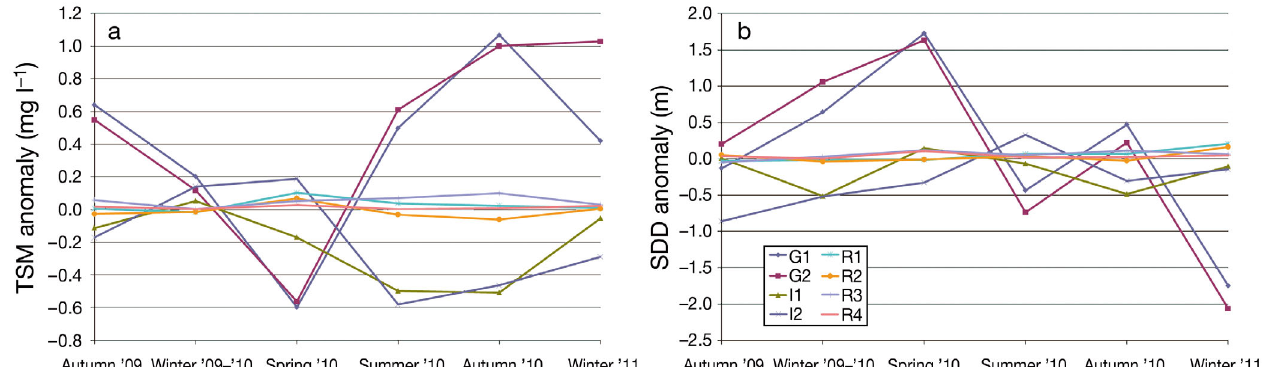
Fig. 6. Seasonal anomalies of (a) total suspended matter (TSM) and (b) Secchi disk depth (SDD) in the impact zones (differences from Zone A1, i.e. the entire bay). See Fig. 1 for impact zone